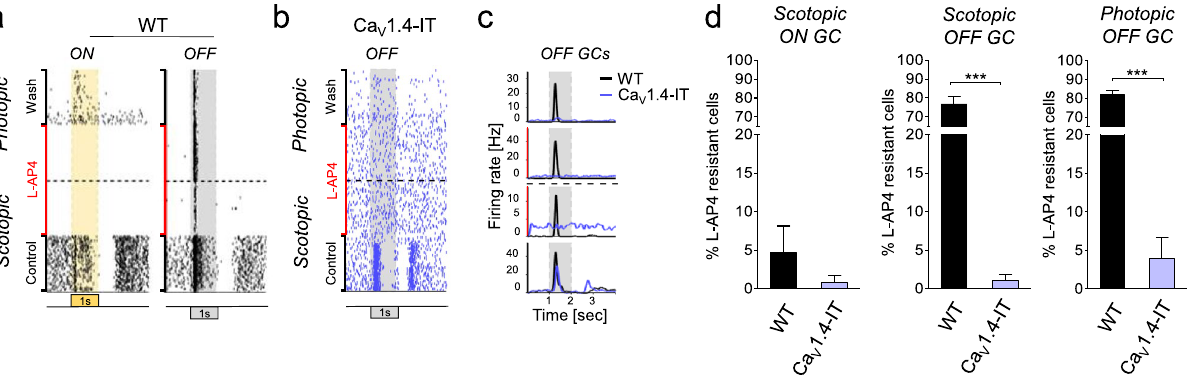
Figure 4. Defective OFF signalling pathways in Ca V 1.4-IT retinas. OFF pathways were pharmacologically isolated by application of 50 μm L-AP4 (red). Ganglion cell spiking activity was recorded during scotopic and photopic illumination (separated by the horizontal dashed line), in the absence (control, wash) or presence of L-AP4 (red). For each condition 40 repetitions of the same stimulus are shown. ( a ) Representative examples of ON ganglion cell activity upon a positive contrast flash (yellow) and OFF ganglion cell activity upon negative contrast flash (grey). Note that in the presence of L-AP4, Ca V 1.4-IT OFF ganglion cells did not anymore respond to light ( b ). Panel ( c ) show the superimposed peri-stimulus time histogram of the OFF ganglion cells shown in ( a , b ): from bottom to top: scotopic—control, scotopic—L-AP4, photopic—L-AP4, and wash out (wash).( d ) Percentage of ganglion cells responding under L-AP4 perfusion upon different light levels. Of note, no responding ON ganglion cells were detected under photopic conditions. The number of responding cells prior to perfusion with L-AP4 (WT, ON n = 70; OFF n = 78; Ca V 1.4-IT, ON n = 91; OFF n = 189) was set to 100%. Percentage of responding ganglion cells under L-AP4 perfusion (% L-AP4 resistant cells): scotopic: WT: OFF: 76.9 ± 3.8, ON: 4.8 ± 3.4; Ca V 1.4-IT: OFF: 1.04 ± 0.7, ON: 0.8 ± 0.8; photopic: WT OFF: 81.9 ± 2.4, ON: none;